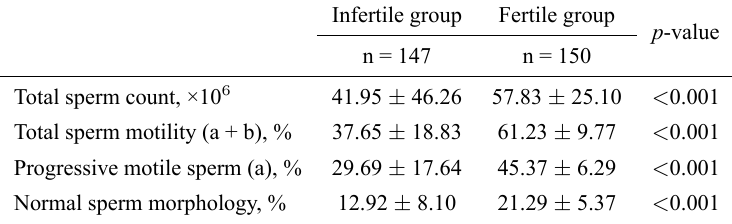
Table 2. Semen analyse characteristics of patients according to the groups. Infertile